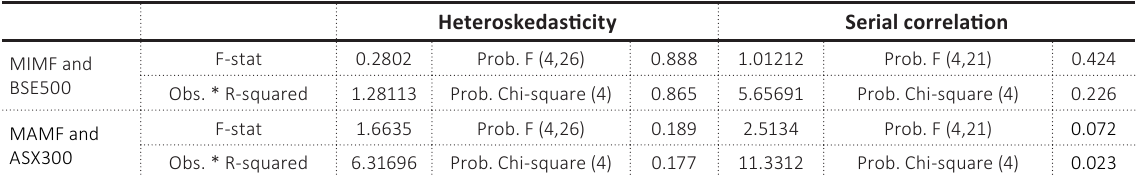
Table 11. Heteroskedasticity and serial correlation test Source: Output extract from EViews software. Heteroskedasticity Serial